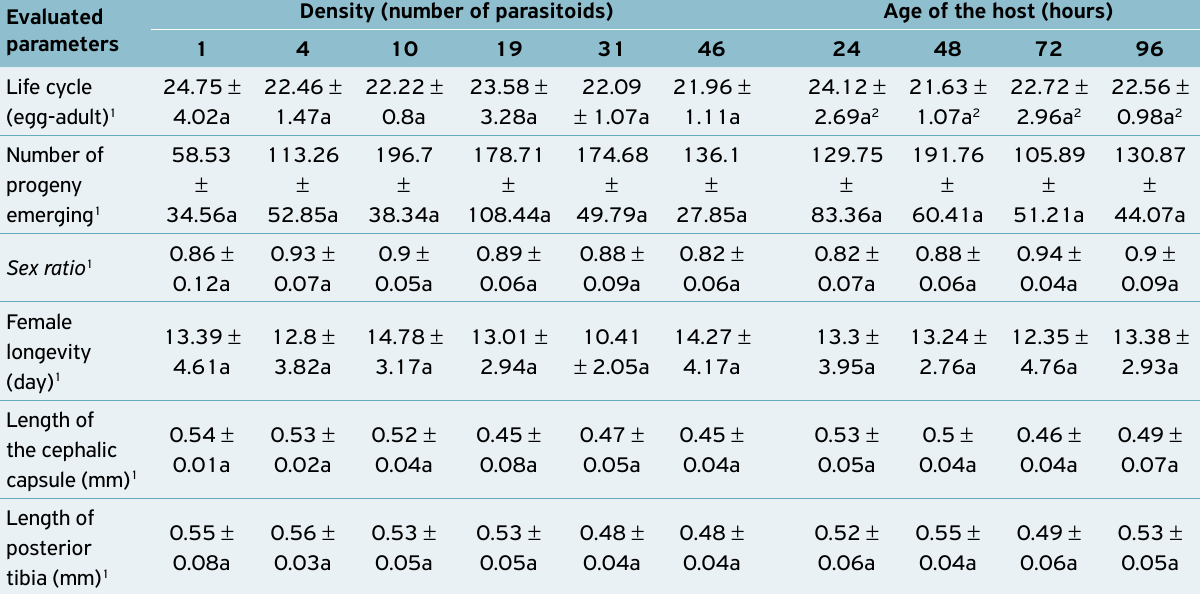
Table 1. Biological variables (mean ± standard deviation) of Palmistichus elaeisis (Hymenoptera: Eulophidae) in pupae of Spodoptera frugiperda (Lepidoptera: Noctuidae) with different parasitism and host age densities at 25 ± 2°C, 60 to 80% 70 ± 10% relative humidity and 12 hours